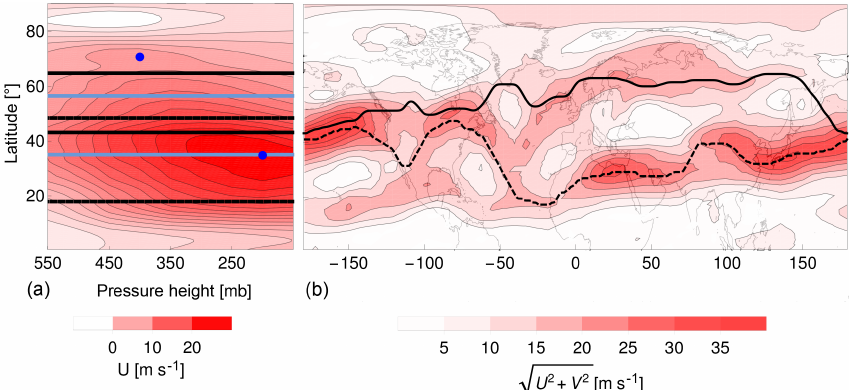
Figure 7. Fifteen-day running mean around 12 May 1979. The right panel shows only a maximum in the wind field in the region between 0 and 100 ◦ E and around 70 ◦ N latitude, which is the reason why the mean jet stream core found with Dijkstra’s algorithm (light-blue line) does not match with the jet stream core found by Rikus’ algorithm (blue circle)